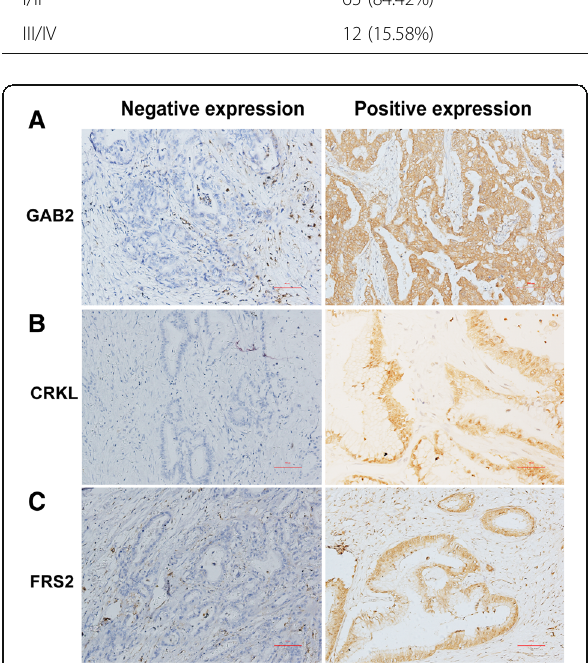
Fig. 1 Expression of GAB2, CRKL and FRS2: GAB − /+ expression ( a ) CRKL − /+ expression ( b ) FRS2 − /+ expression ( c ). Magnification ×